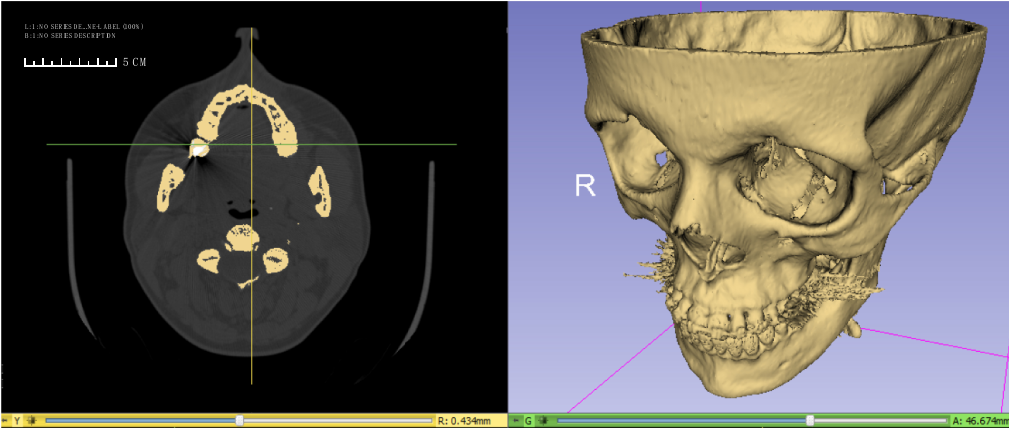
Figure 1. Computer tomography (CT) parallel scan slice with a separate three-dimensional finite element model of craniofacial skeleton of 32-year-old women with skeletal malocclusion (Slicer 4.10.2 ® ).